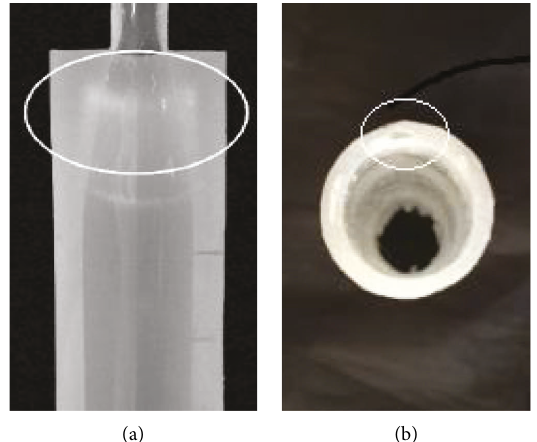
Figure 9: OWAIM to form holes caused by cooling shrinkage at end position, (a) the melt accumulation and (b) the concave holes.